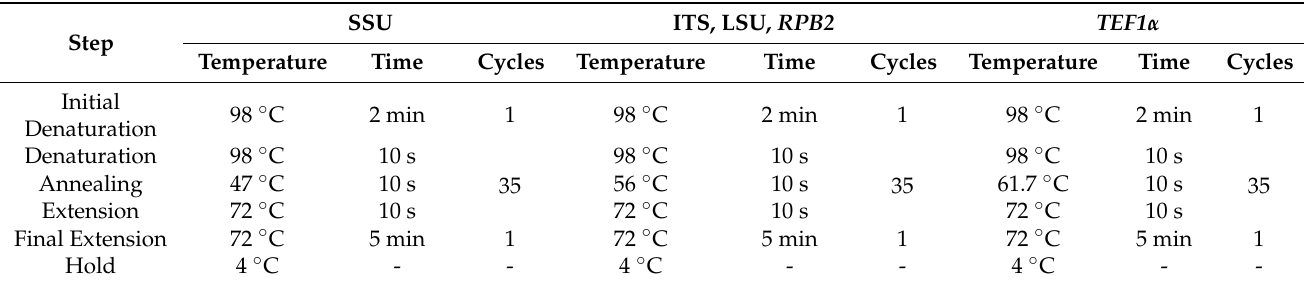
Table 1. PCR thermal cycles for SSU, ITS, LSU, RPB2 and TEF1 α amplification.